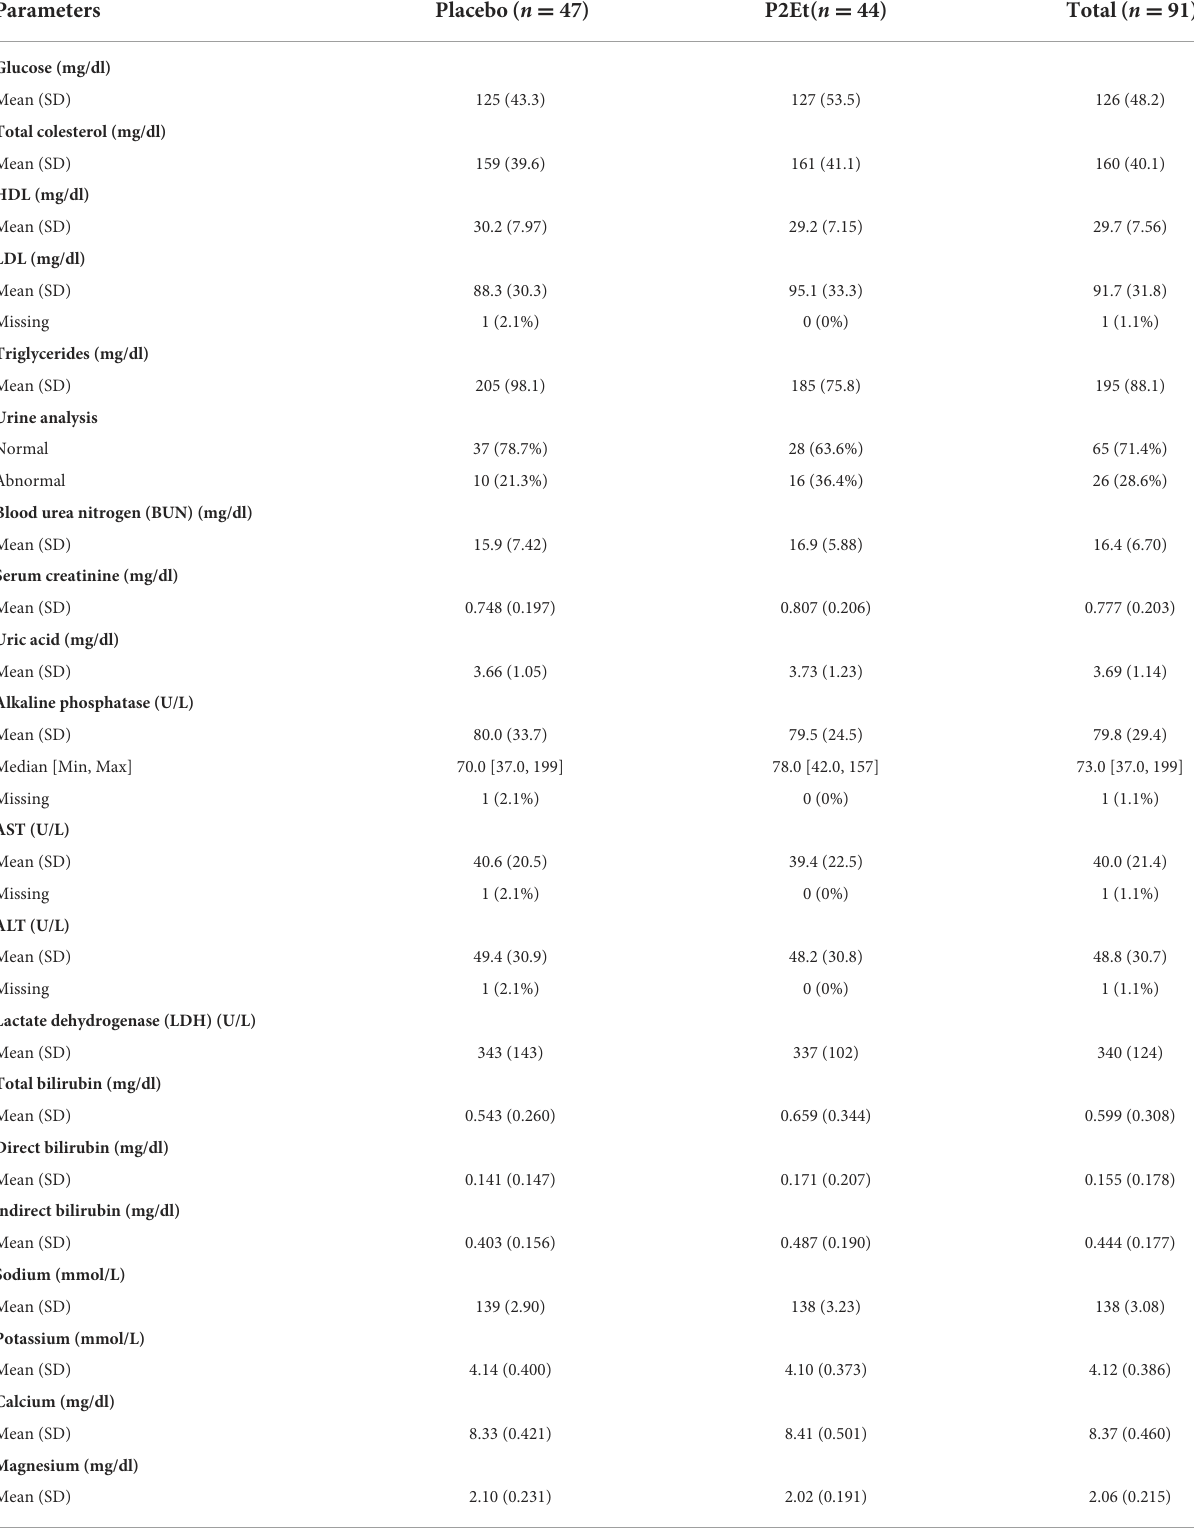
TABLE 2 Clinical characteristics of the patients enrolled in